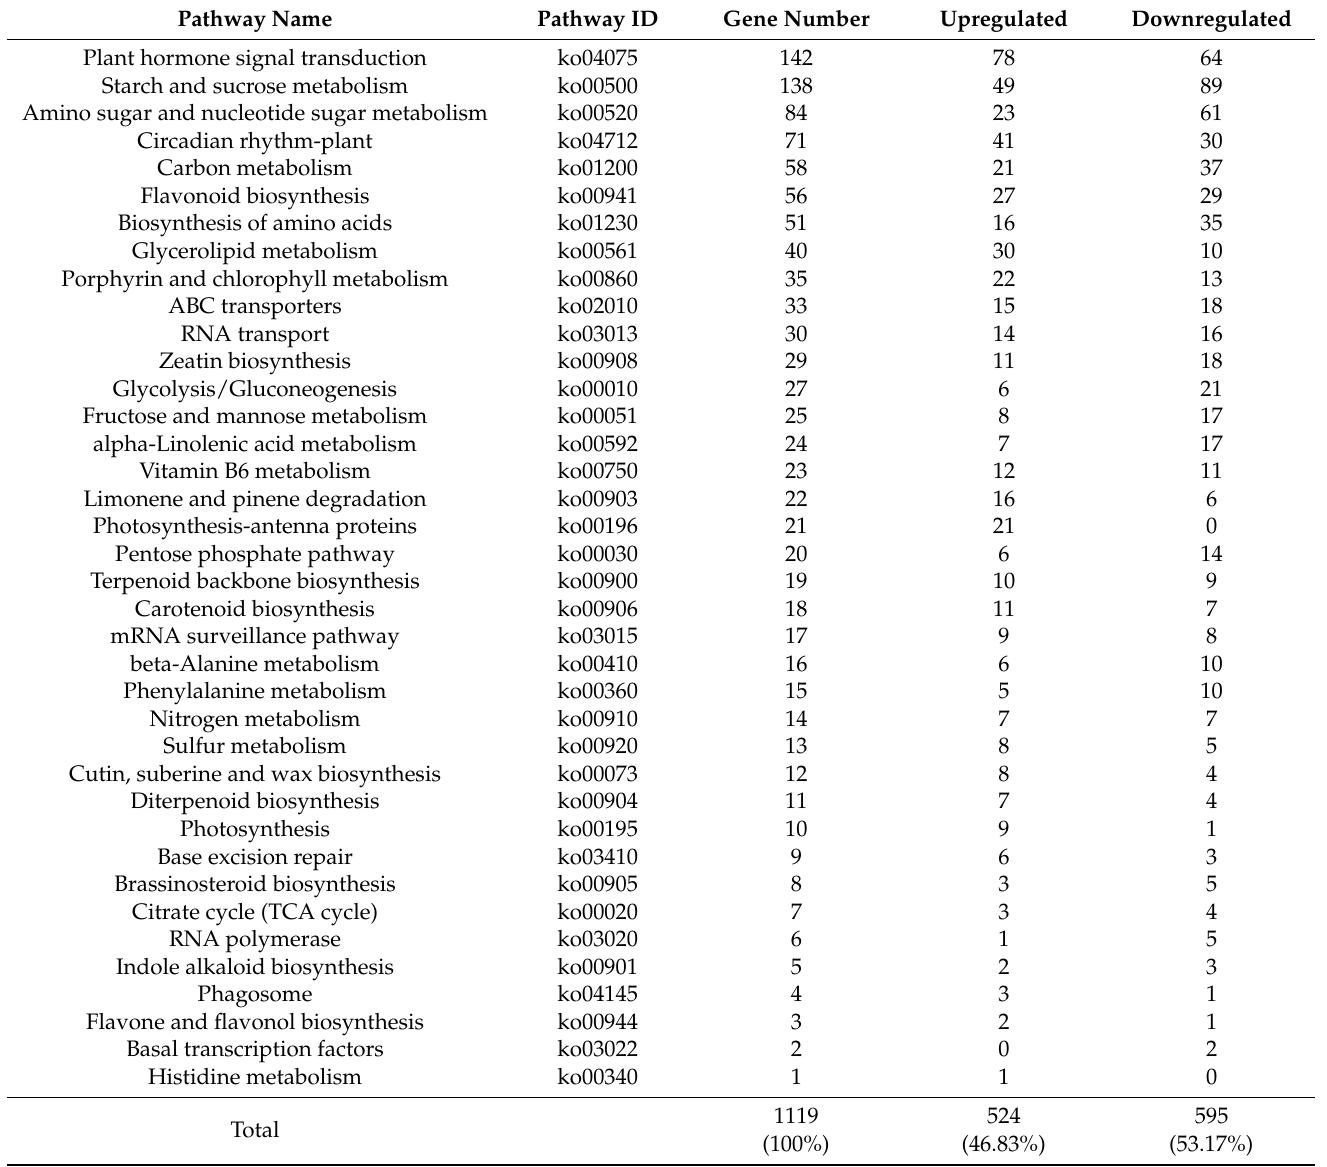
Table 1. KEGG pathways are related to hormone signaling and intracellular